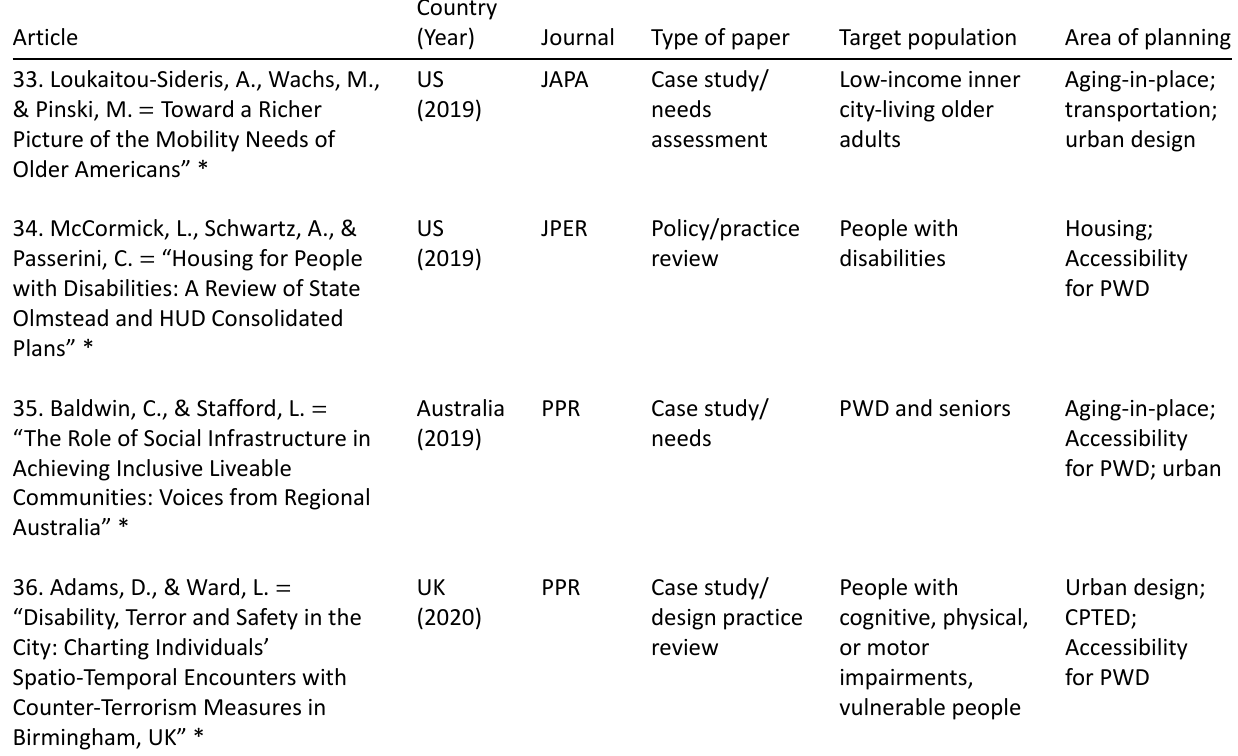
Table 3. (Cont.) Summary of reviewed